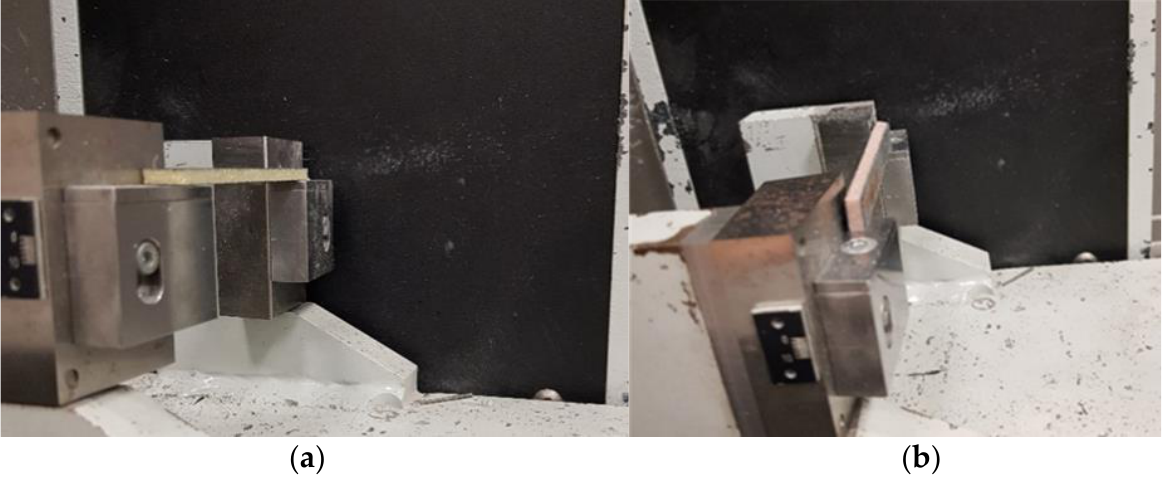
Figure 2. Sample placed for impact testing under: ( a ) edgewise loading and ( b ) flatwise loading. Ten samples were tested for each loading configuration and for each composite.